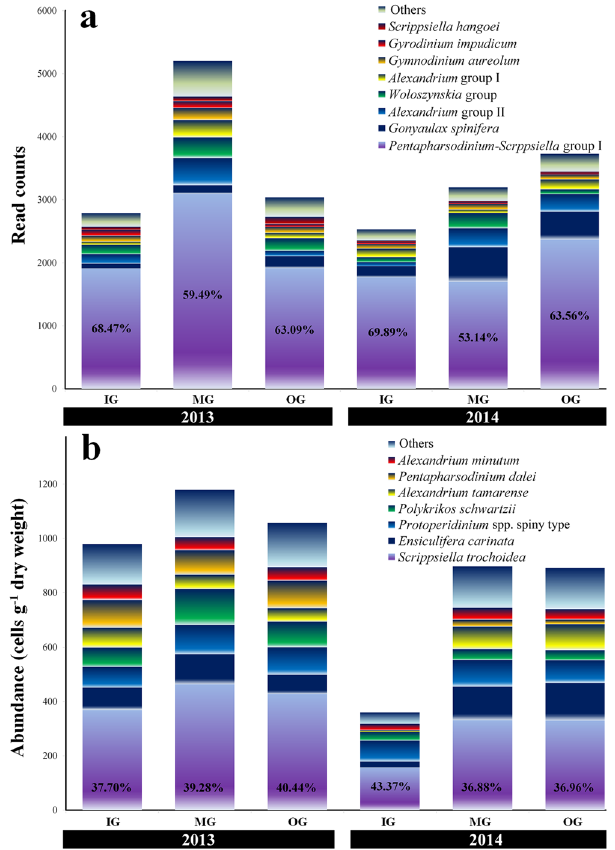
Figure 2. Common species (or genus) composition-inferred assemblages of dinoflagellate cysts based on next- generation sequencing ( a ) and morphological data ( b ) in surface sediments of Tongyeong coast (South Sea) of South Korea during December 2013 and September 2014. IG, inner group; MG, middle group; OG, outer